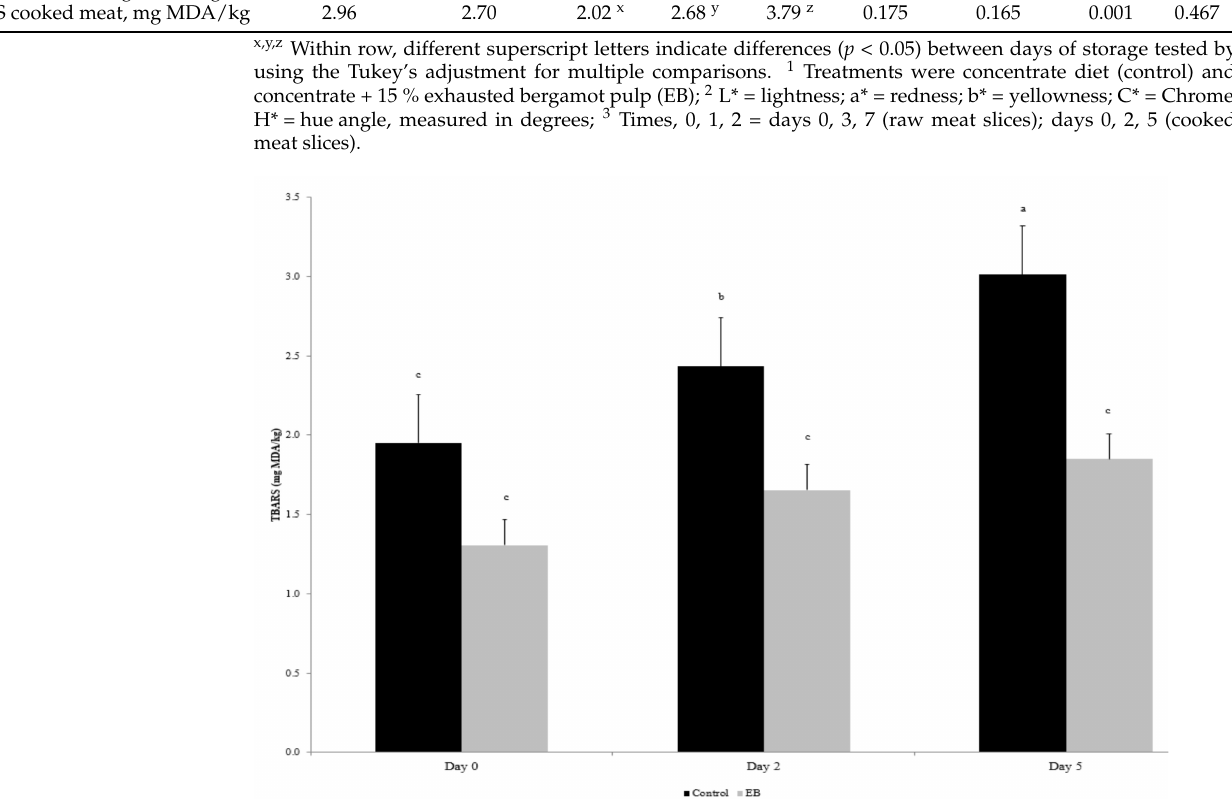
Figure 1. Lipid oxidation (TBARS assay) measured in salami slices over 5 days of aerobic storage at 4 ◦ C. Values are the means and standard error bars. a,b,c Different letters indicate differences between means ( p ≤